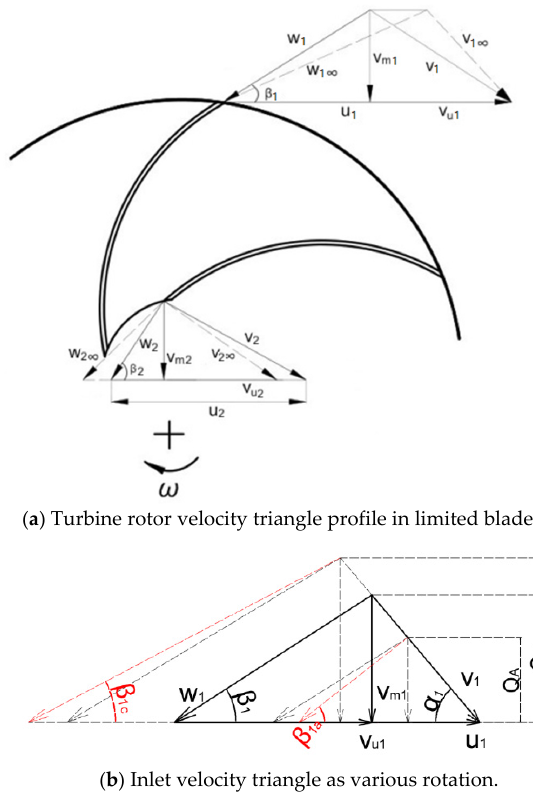
Figure 4. Performance curves of turbine by test.